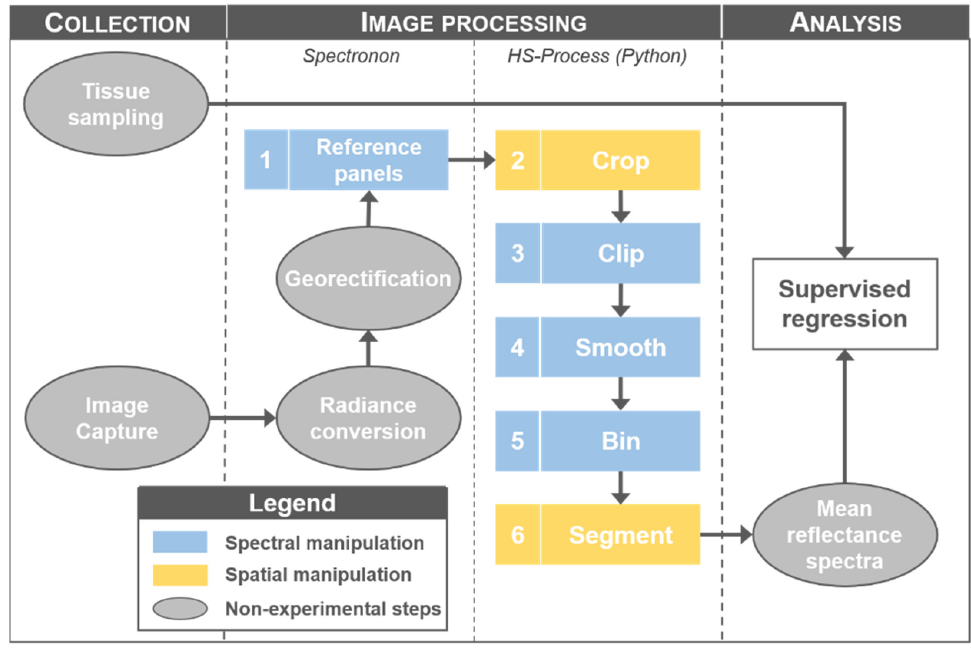
Figure 1. Data collection, image processing, and analysis steps leading up to training and testing the supervised regression models. The grey ovals represent the steps that were consistent across all processing scenarios, whereas the numbered rectangles represent the subjective processing steps evaluated in this study.